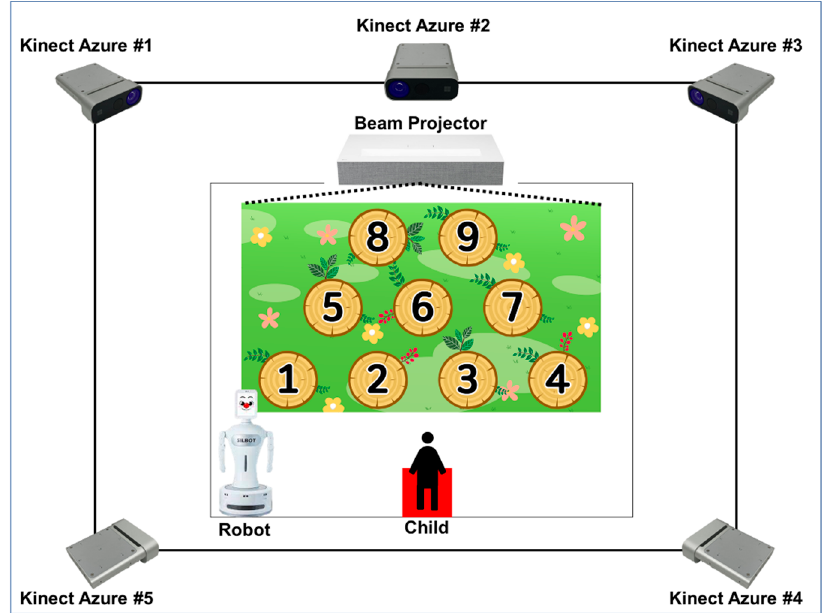
Figure 1. System for acquiring skeleton data for attention deficit hyperactivity disorder (ADHD) screening of children. Five Kinect Azure devices were used to acquire skeleton data and a beam projector and a robot were used to run the game.